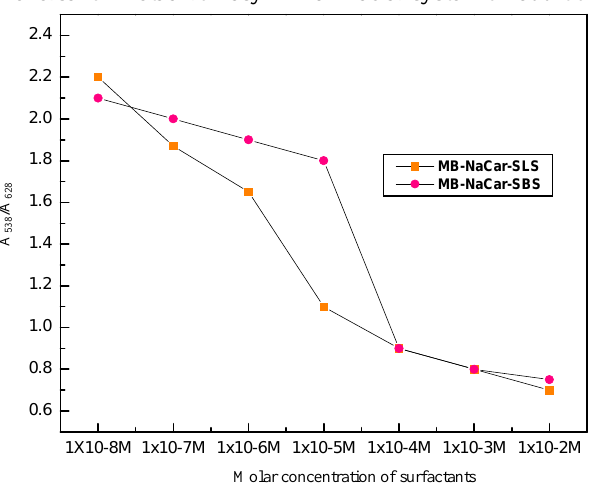
Figure 11. Reversal of metachromasy in AO-NaCar system on addition of surfactants